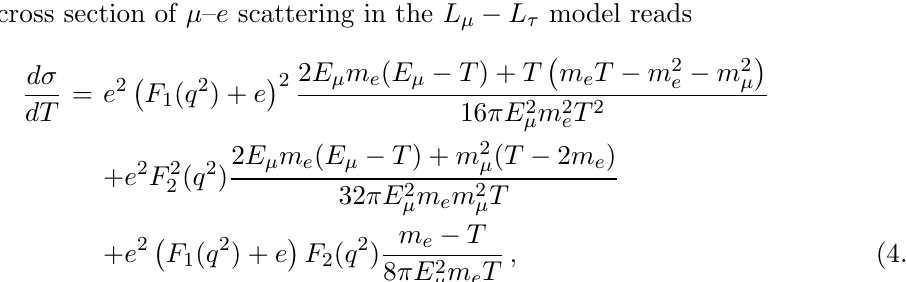
2 ) =(cid:21) (left) and F 2 ) =(cid:21) (right) on the Z 1 ( q 2 ( q eg 2 = 16 (cid:25) 2 . Z 0 (cid:17)